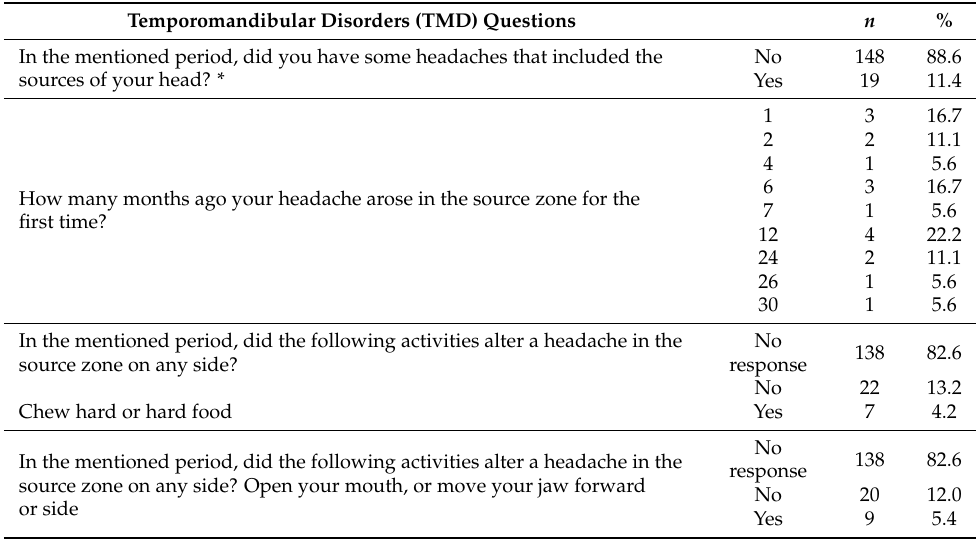
Table 2. Frequency of responses to TMD